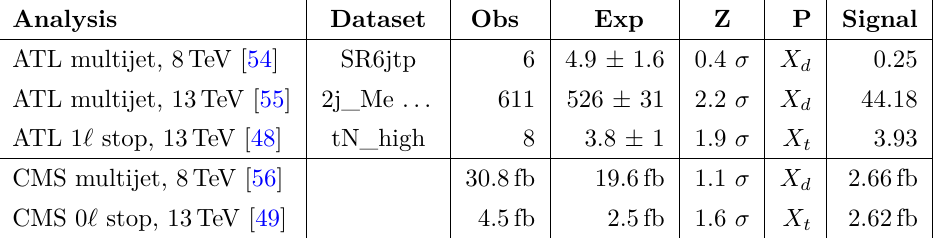
Table 3 . Analyses contributing to the K value of the highest score proto-model from figure 8. Listed are the signal region (SR) where applicable, the number of observed events or observed upper limit (Obs), the expected background and its uncertainty or the expected upper limit (Exp), the significance (Z) of the excess, and which proto-model particle (P) is introduced for fitting the observed data. The last column (Signal) shows the predicted contribution of the proto-model, in number of events for EM results (ATLAS, ATL for short) and in fb for UL results (CMS). Analysis (all CMS 13 TeV)